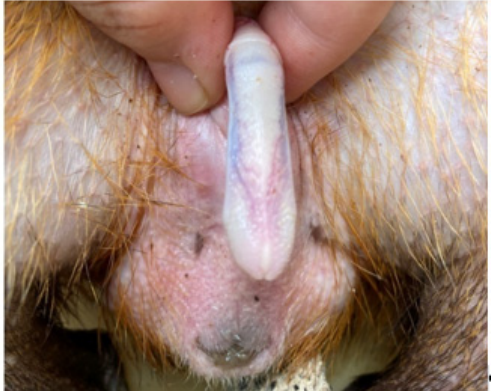
Figure 2. Dorsal view of penis .